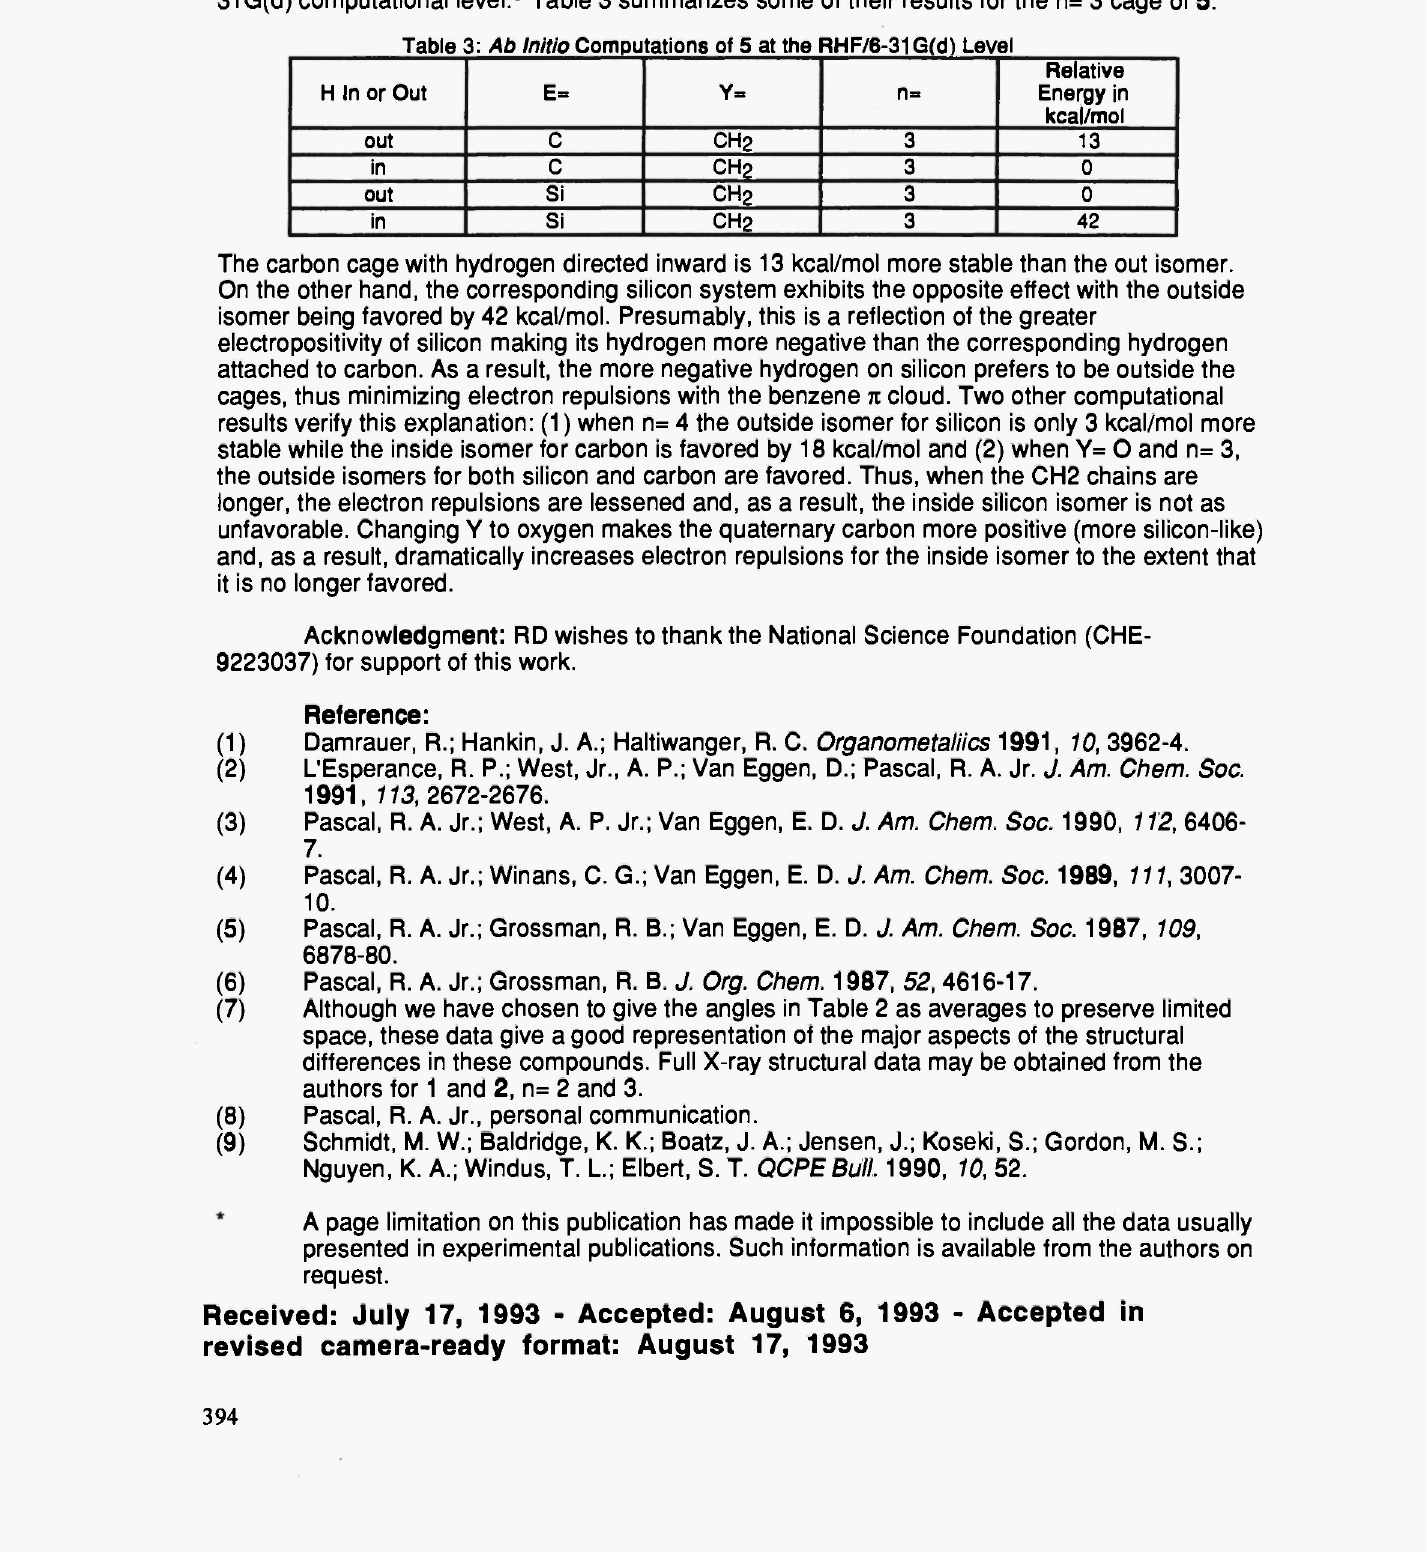
Table 3: Ab Initio Computations of 5 at the RHF/6-31 G(d)